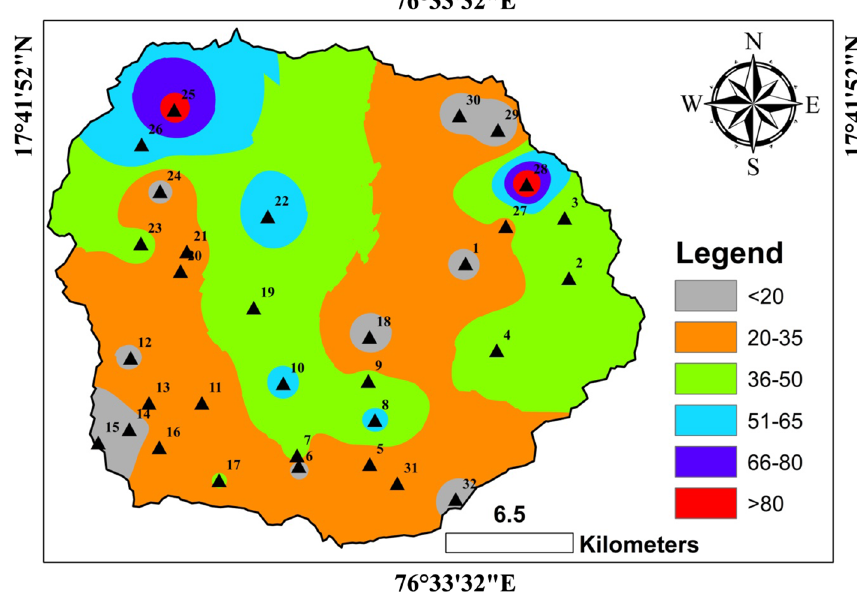
Fig. 29 Geospatial distribution of sulphate